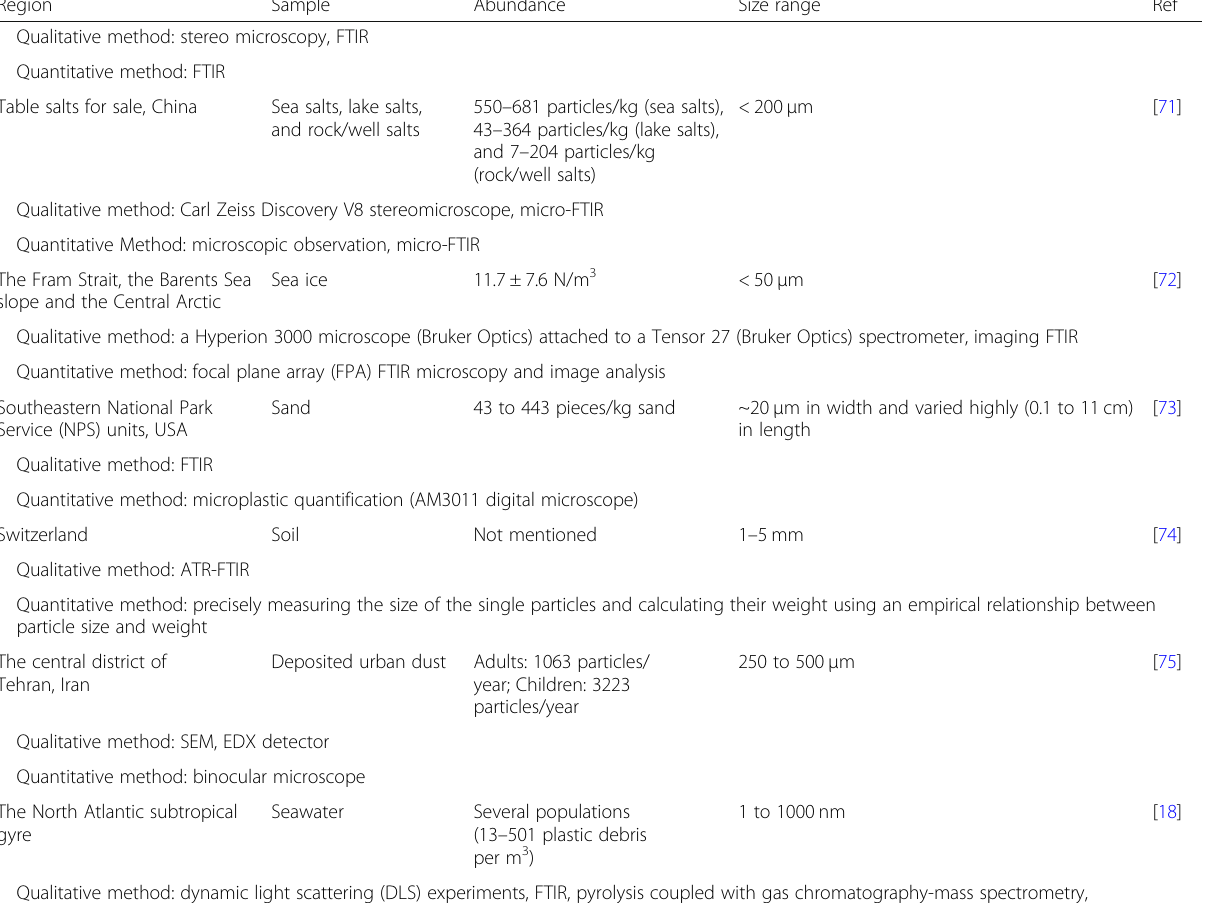
Table 1 Summary of published studies providing data on abundance, size range, and qualitative and quantitative methods of micro- and nanoplastics (MNPs) from 2016 to 2020